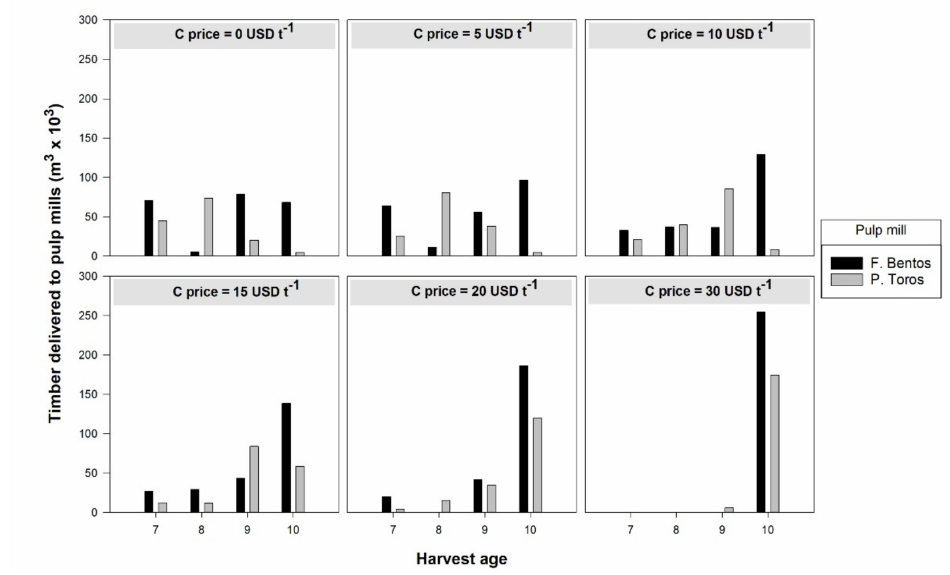
Figure 4. Timber delivered to pulp mills by C price and harvest age assuming 50% of C released at the harvest time, an IR of 8%, and a timber price of 65 USD m − 3